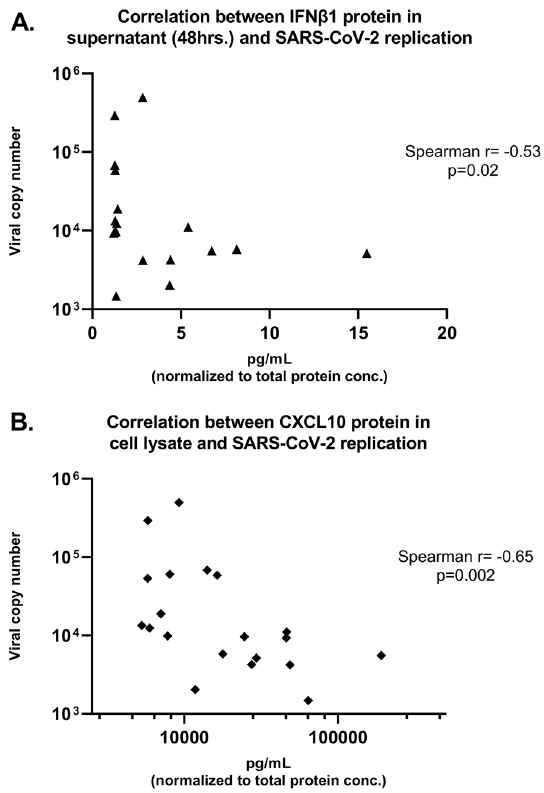
Figure 5. Correlation between secreted IFNβ1 concentration 48 h after SARS-CoV-2 WA-01 infection or CXCL10 concentration from the cell lysate 96 h after SARS-CoV-2 WA-01 infection (normalized to total protein concentration) and 96-h replication of SARS-CoV-2 by quantitative PCR in primary bronchial epithelial cell cultures in children (n = 14) and adults (n = 8). Secreted IFNβ1 and SARS-CoV-2 replication were significantly inversely correlated [( A ) Spearman r = − 0.53, p = 0.02], and CXCL10 concentration from cell lysates was also significantly inversely correlated with SARS-CoV-2 replication [( B ) Spearman r = − 0.65, p =